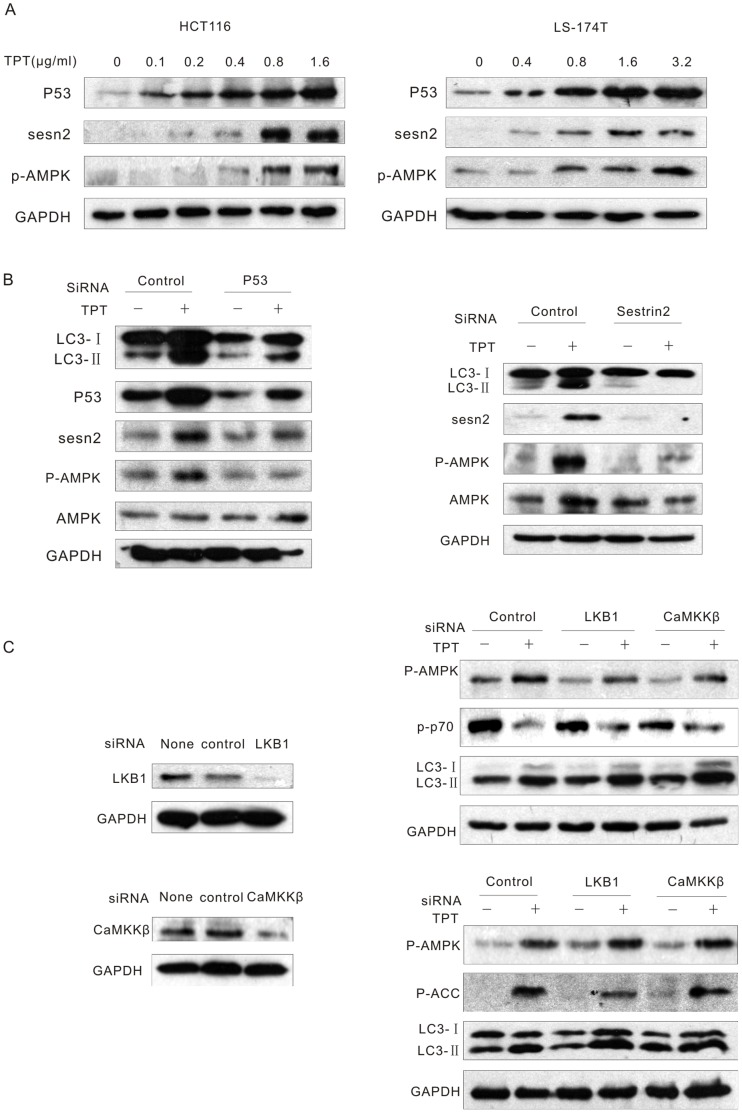
P53 mediates topotecan-induced autophagy through the activation of sestrin 2 and AMPK in colon cancer cells with wild-type p53.
A. HCT116 and LS-174T cells were treated with various concentrations of TPT for 24 h. The levels of P53, sestrin2 and p-AMPK were analysed by immunoblotting. B. HCT116 cells were transfected with p53 or sestrin 2 siRNAs for 24 h, treated with or without 1 µg/mL TPT for an additional 24 h, and the indicated proteins were then analysed by immunoblotting. C. HCT116 cells were transfected with LKB1 or CaMKKβ siRNAs, treated with or without 1 µg/mL TPT for an additional 24 h, and the indicated proteins were detected by immunoblotting.